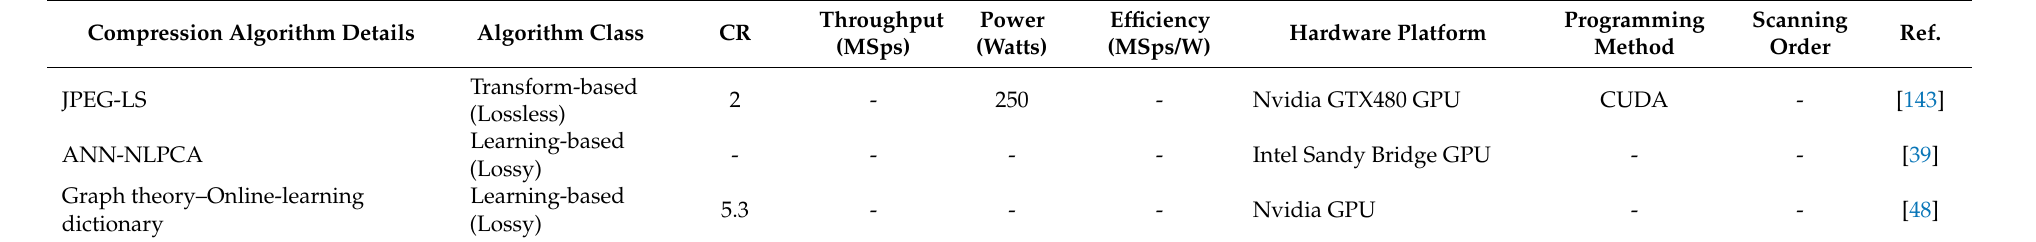
Table 15. Comparison of the proposed compression system validated using the AVIRIS Lunar Lake